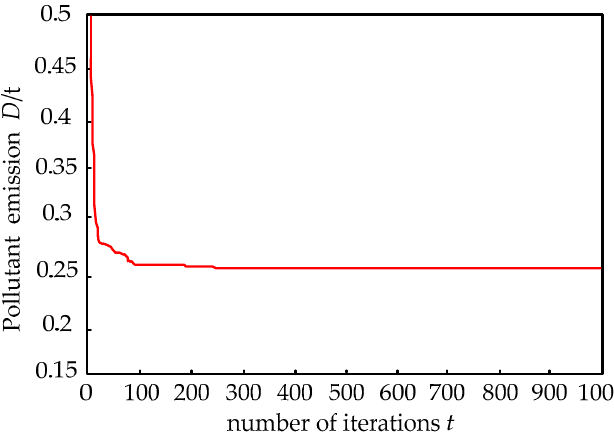
Figure 13. The change curve of economic costs with the number of iterations (improved SPSO).